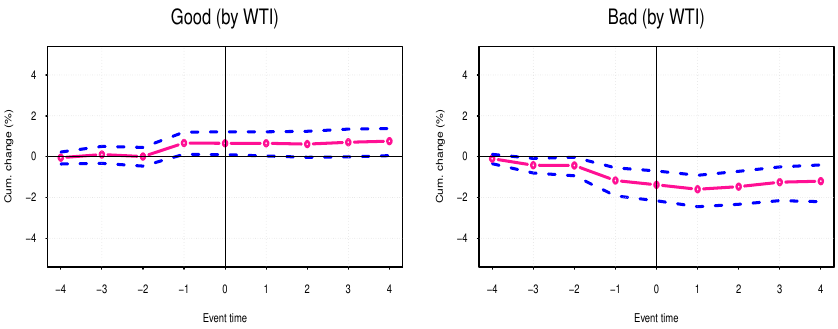
Figure 5. Extreme event on WTI oil and response of Tech.